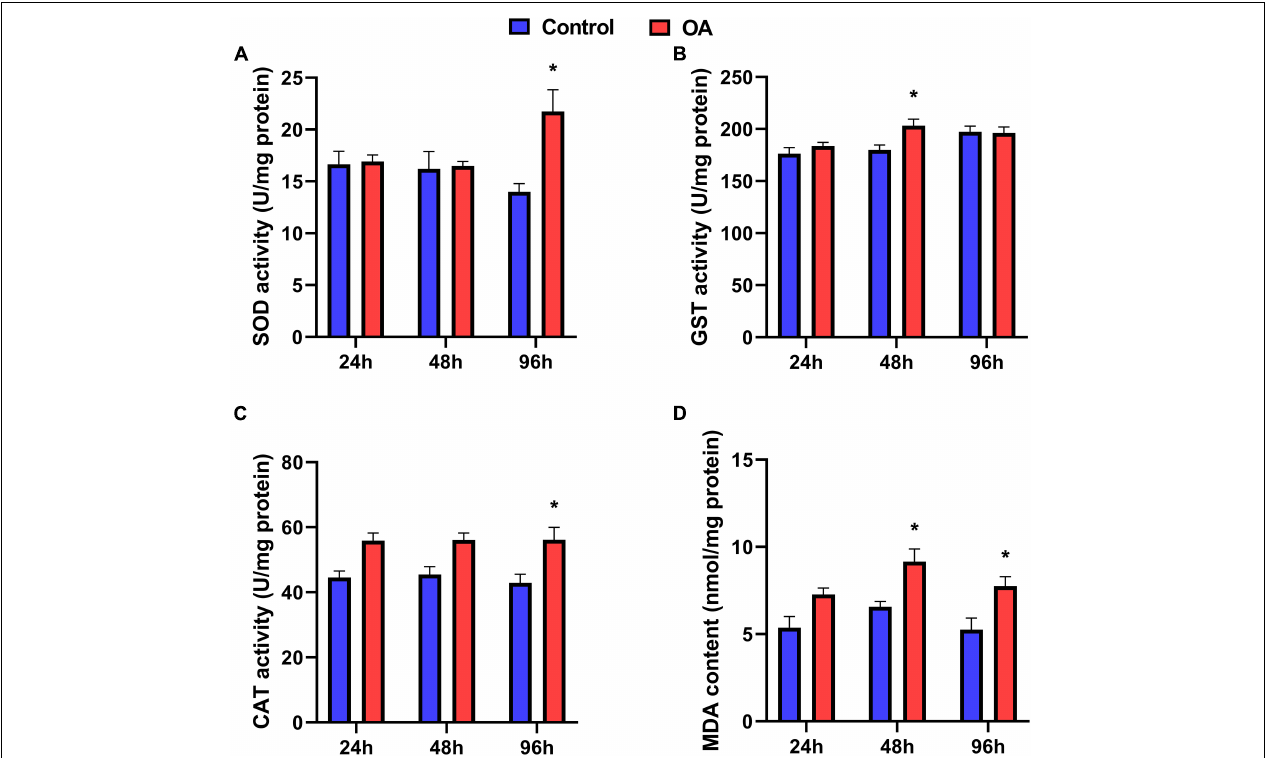
FIGURE 1 | Activities of SOD (A) , GST (B) , CAT (C) , and MDA content (D) of C. farreri exposed to OA ( n = 5). Asterisks indicate significant differences between the control and OA-exposed group within each fixed sampling period, and different letters indicate significant differences among different sampling periods within each treatment ( p <